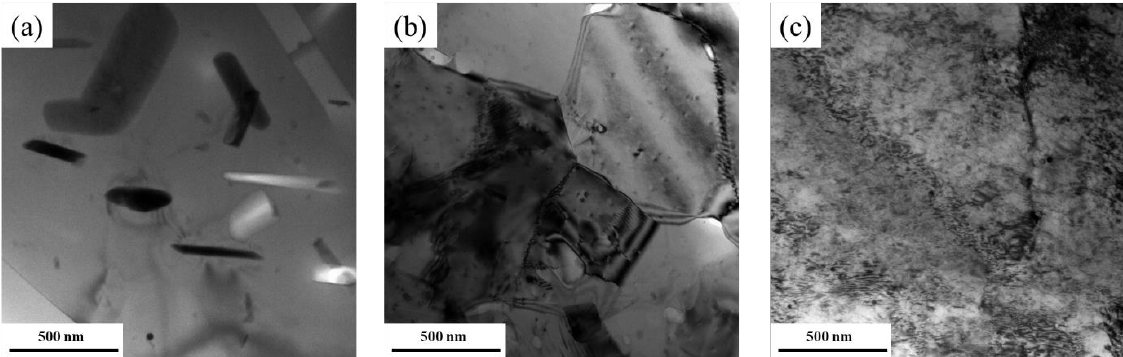
Figure 6. TEM images of the 7085 alloy after forging deformation: ( a ) HTD; ( b ) MTD; ( c )